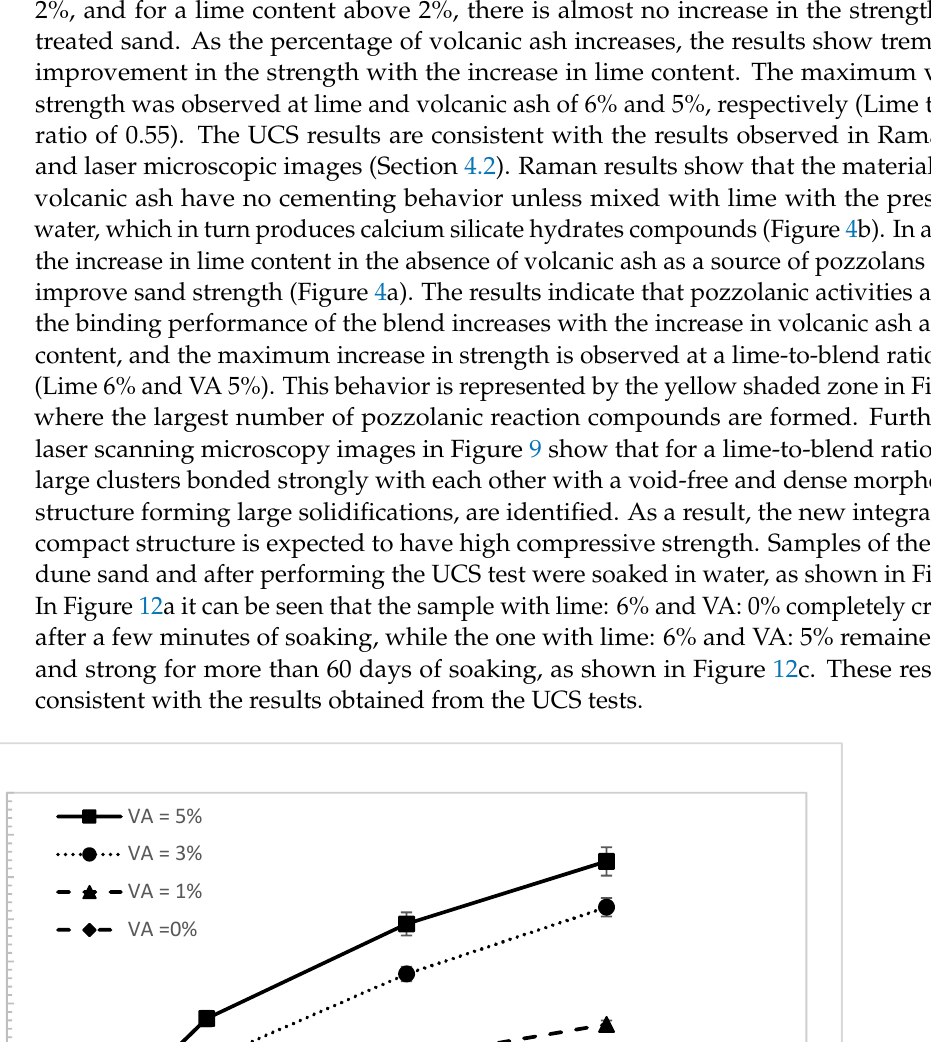
Figure 11. ( a ) UCS-test, ( b ) CBR test, and ( c ) CBR-tested sample.